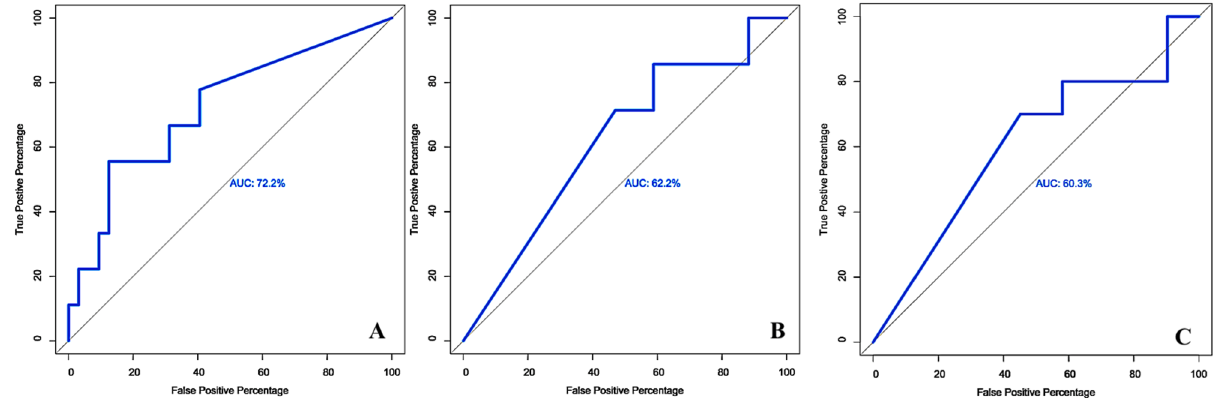
Figure 2. Receiver operating characteristic (ROC) curve analysis and corresponding area under the curve (AUC) analysis on PBQ dataset when milk qPCR ( A ), milk ELISA ( B ), serum ELISA ( C ) were binary reference models.